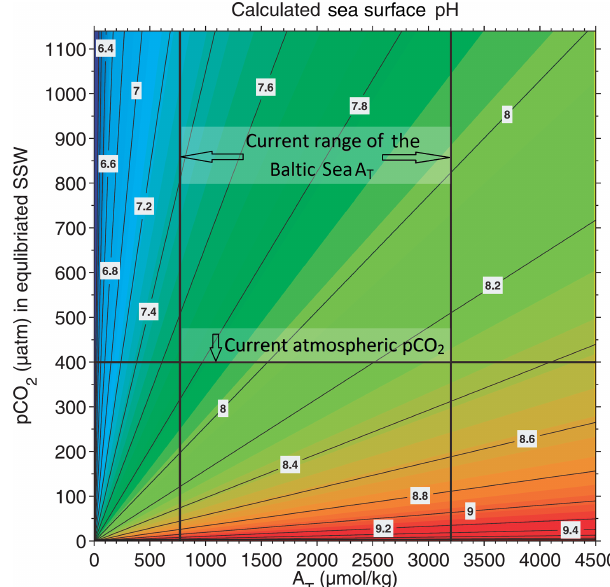
Figure 4. Distribution of pH tot as a function of A T and pCO 2 at a salinity of 7.5 and temperature of 0 ◦ C (modified after Omstedt et al., 2010). The A T range represents findings by Beldowski et al. (2010). SSW is an abbreviation for surface